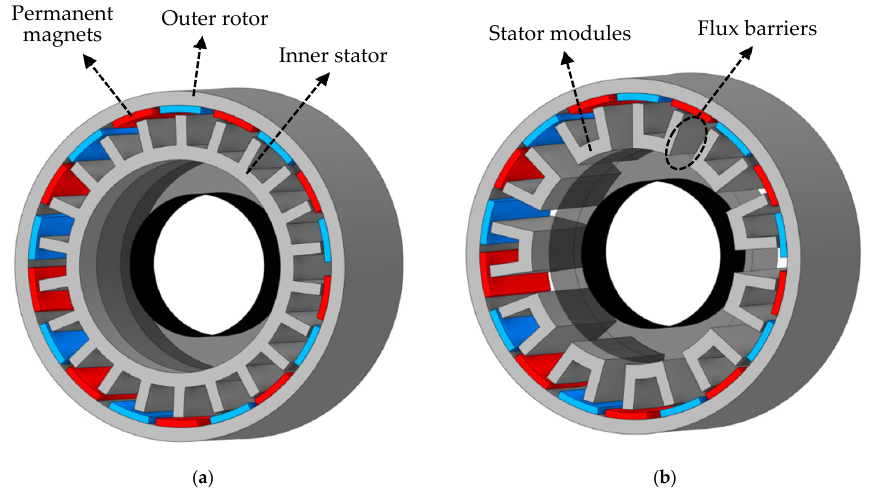
Figure 1. Three ‐ dimensional representation of stator/rotor structure of a 24 ‐ slot, 20 ‐ pole PMSM: ( a ) Figure 1. Three-dimensional representation of stator/rotor structure of a 24-slot, 20-pole PMSM: conventional PMSM with non ‐ segmented stator (monolithic), ( b ) PMSM with modular stator core ( a ) conventional PMSM with non-segmented stator (monolithic), ( b ) PMSM with modular stator core (MPMSM).